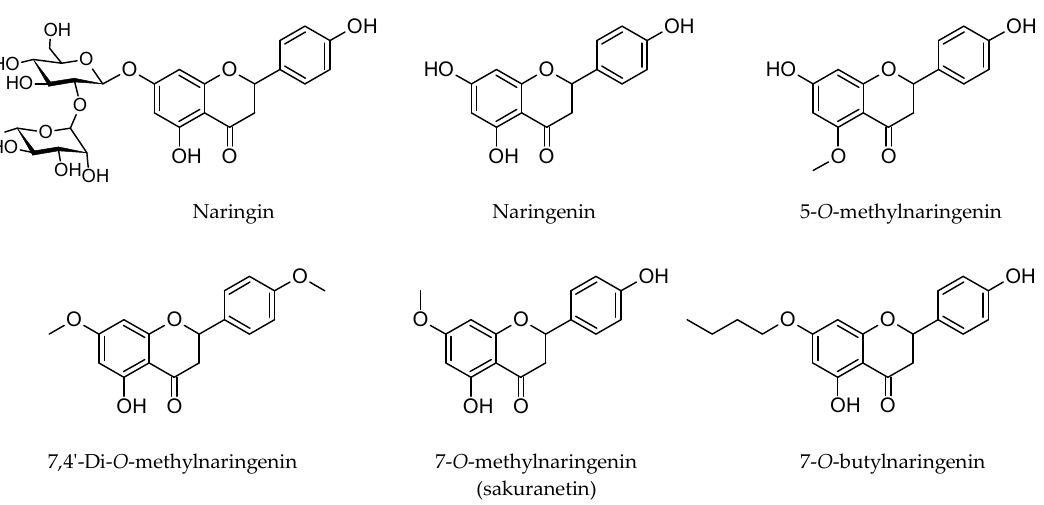
Figure 1. Structures of naringin, naringenin and naringenin derivatives.